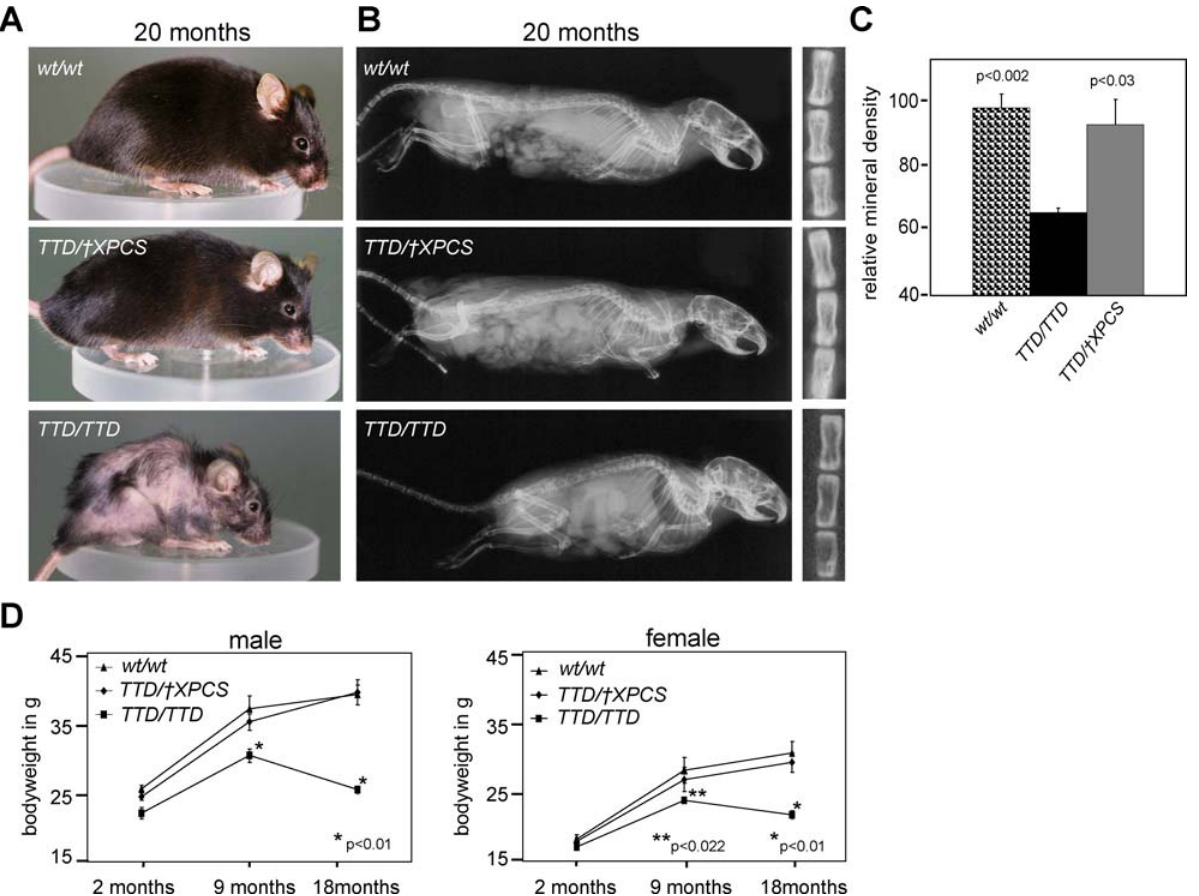
Figure 3. Rescue of TTD-Associated Segmental Progeroid Features in Compound Heterozygous Xpd TTD/ (cid:1) XPCS Mice (A) Photographs of 20-mo-old wt, compound heterozygous Xpd TTD/ (cid:1) XPCS, and homozygous Xpd TTD/TTD mice. Note the extreme cachexia (lack of subcutaneousfat)inthe Xpd TTD/TTD mouseandtheabsenceofthisphenotypeinwtand Xpd TTD/ (cid:1) XPCS mice. (B) Radiographs of 20-mo-old male wt, Xpd TTD/ (cid:1) XPCS, and Xpd TTD/TTD mice. Ageing Xpd TTD/TTD mice develop kyphosis (curvature of the spinal column) and reduction of bone mineral density as shown in the 6–8 segment of the tail vertebrae counted from the pelvis (see close-up at right). Note the absence of these features in the Xpd TTD/ (cid:1) XPCS mouse. (C) Quantification of relative bone mineral density of tail vertebrae from 20-mo-old male wt ( n ¼ 3), Xpd TTD/ (cid:1) XPCS ( n ¼ 4), and Xpd TTD/TTD ( n ¼ 3) mice. The p -values indicate the significance of the difference relative to Xpd TTD/TTD . Error bars indicate SEM. (D) Body weight curves as a function of time. Note that the age-dependent cachexia observed in Xpd TTD/TTD mice was rescued in both male and female Xpd TTD/ (cid:1) XPCS mice. Significant differences between wt and Xpd TTD/TTD but not between wt and Xpd TTD/ (cid:1) XPCS mice were observed at 9 and 18 mo of age as indicated by asterisks. Error bars indicate SEM. DOI: